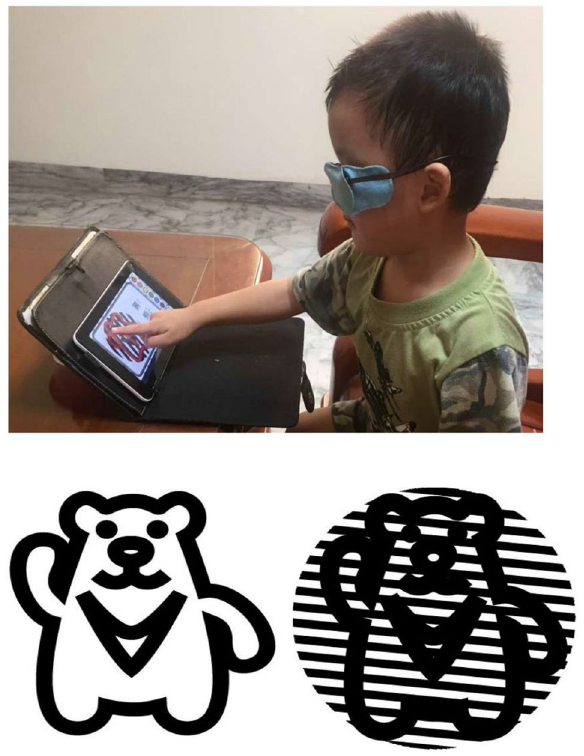
Figure 5. Example of an amblyopic child wearing a patch and playing the training tablet. Bottom panel illustrates two stimuli for the control group (left) and the Grating group (right)